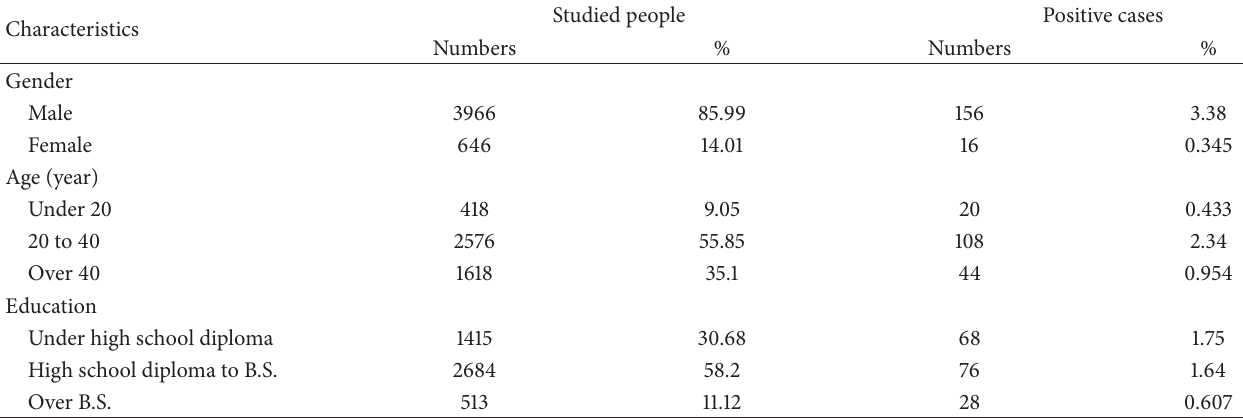
Table 1: The number of positive cases of parasites in food production and distribution centers employees in the city of Tabriz according to individual